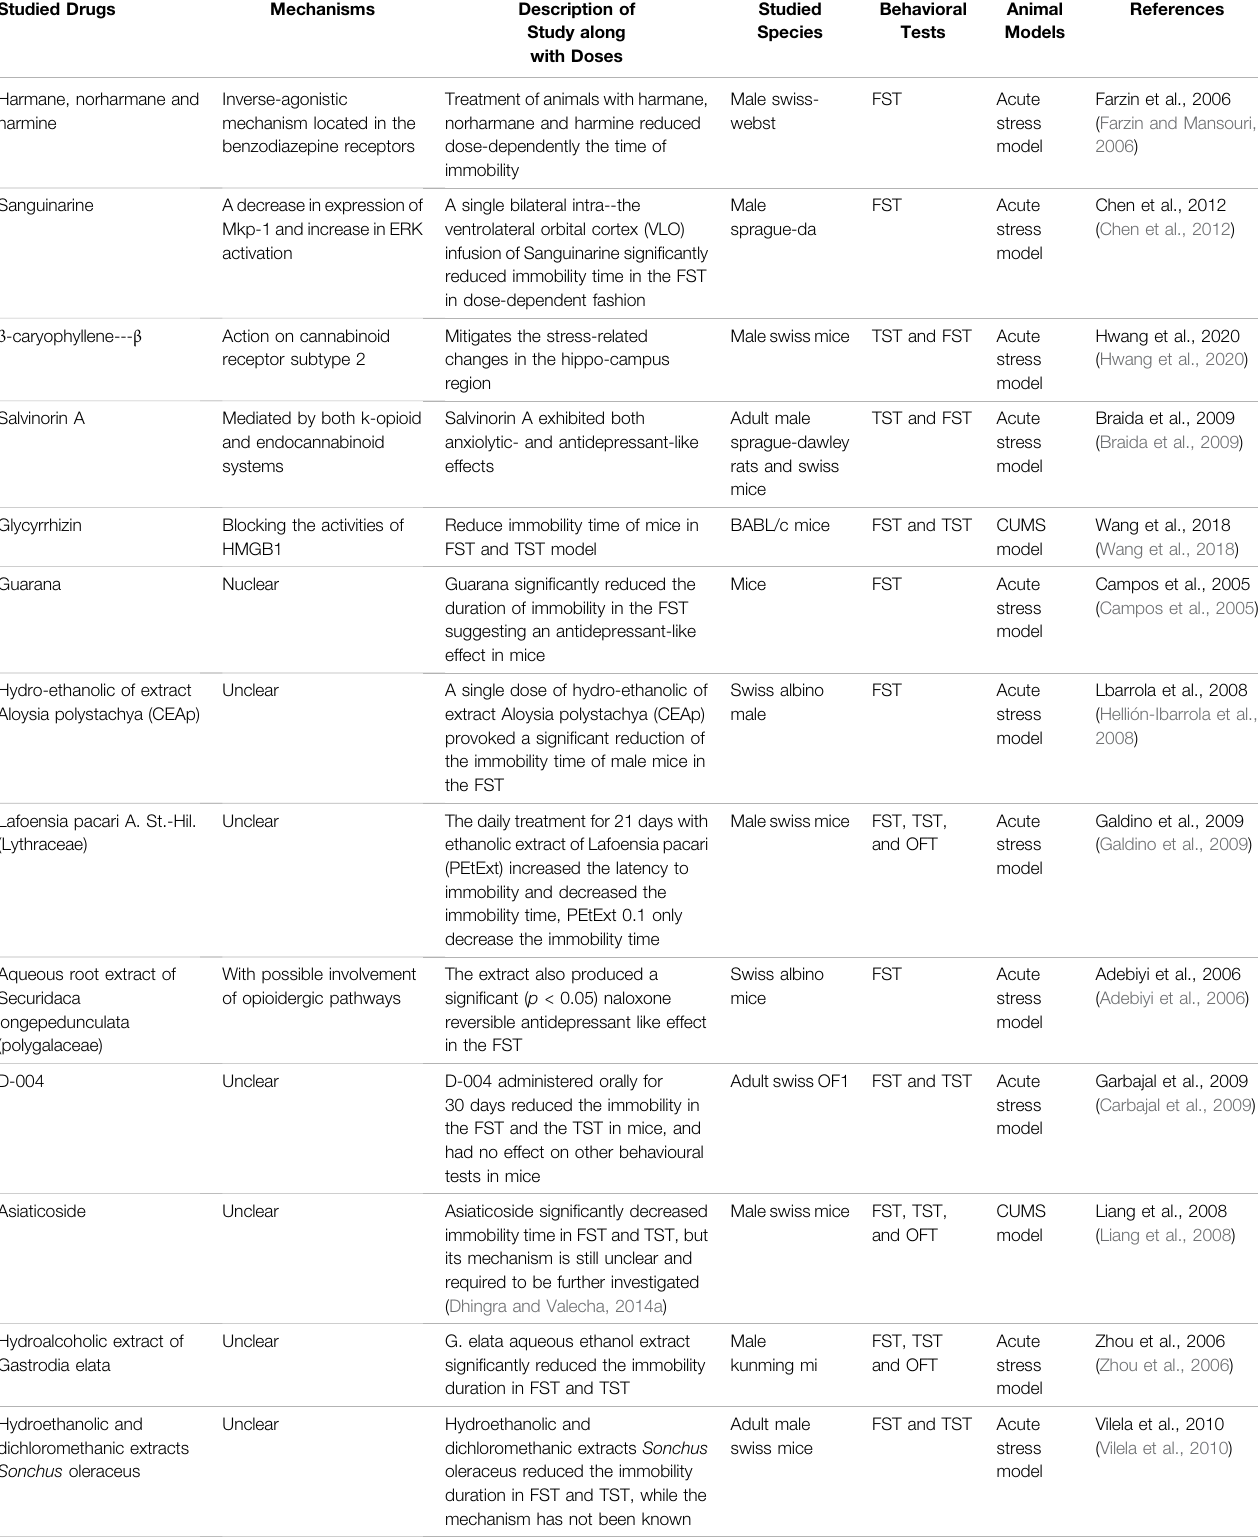
TABLE 4 | Potential natural products for the treatment of PSD by other